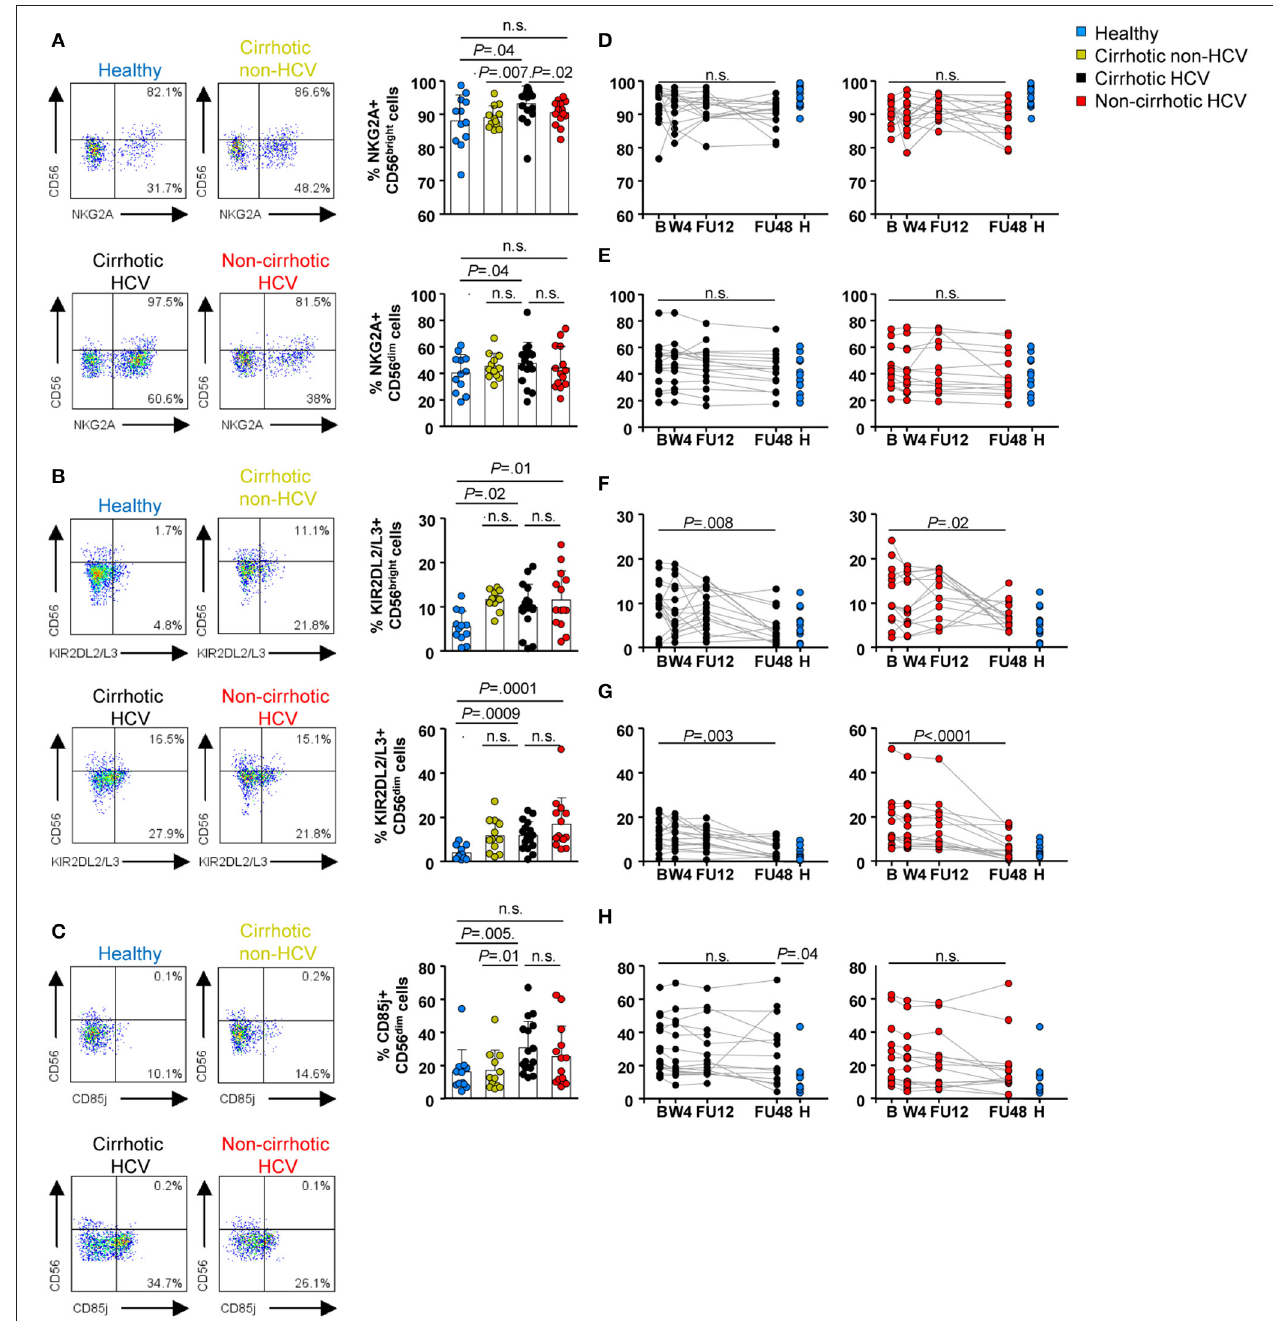
FIGURE 3 | Inhibitory receptor frequencies within NK subpopulations were also upregulated at baseline in HCV patients with cirrhosis and persisted until FU48. Flow cytometric analysis of PBMC samples from 12 healthy individuals (blue), 12 non-HCV cirrhotic controls (yellow), 17 HCV cirrhotic (black), and 14 non-cirrhotic (red) patients. Representative flow cytometry plots and baseline frequencies of NKG2A + (A) , KIR2DL2/L3 + (B) , and CD85j + (C) CD56 bright (above) and CD56 dim (below) cells. Longitudinal analysis during and after IFN-free therapies of NKG2A + CD56 bright cells (D) , NKG2A + CD56 dim cells (E) , KIR2DL2/L3 + CD56 bright cells (F) , KIR2DL2/L3 + CD56 dim cells (G) , and CD85j + CD56 dim cells (H) . Error bars indicate mean + SD; P -values at baseline were determined by Mann–Whitney U test; P -values during longitudinal analysis were determined by mixed models for repeated measurements. n.s., not significant.